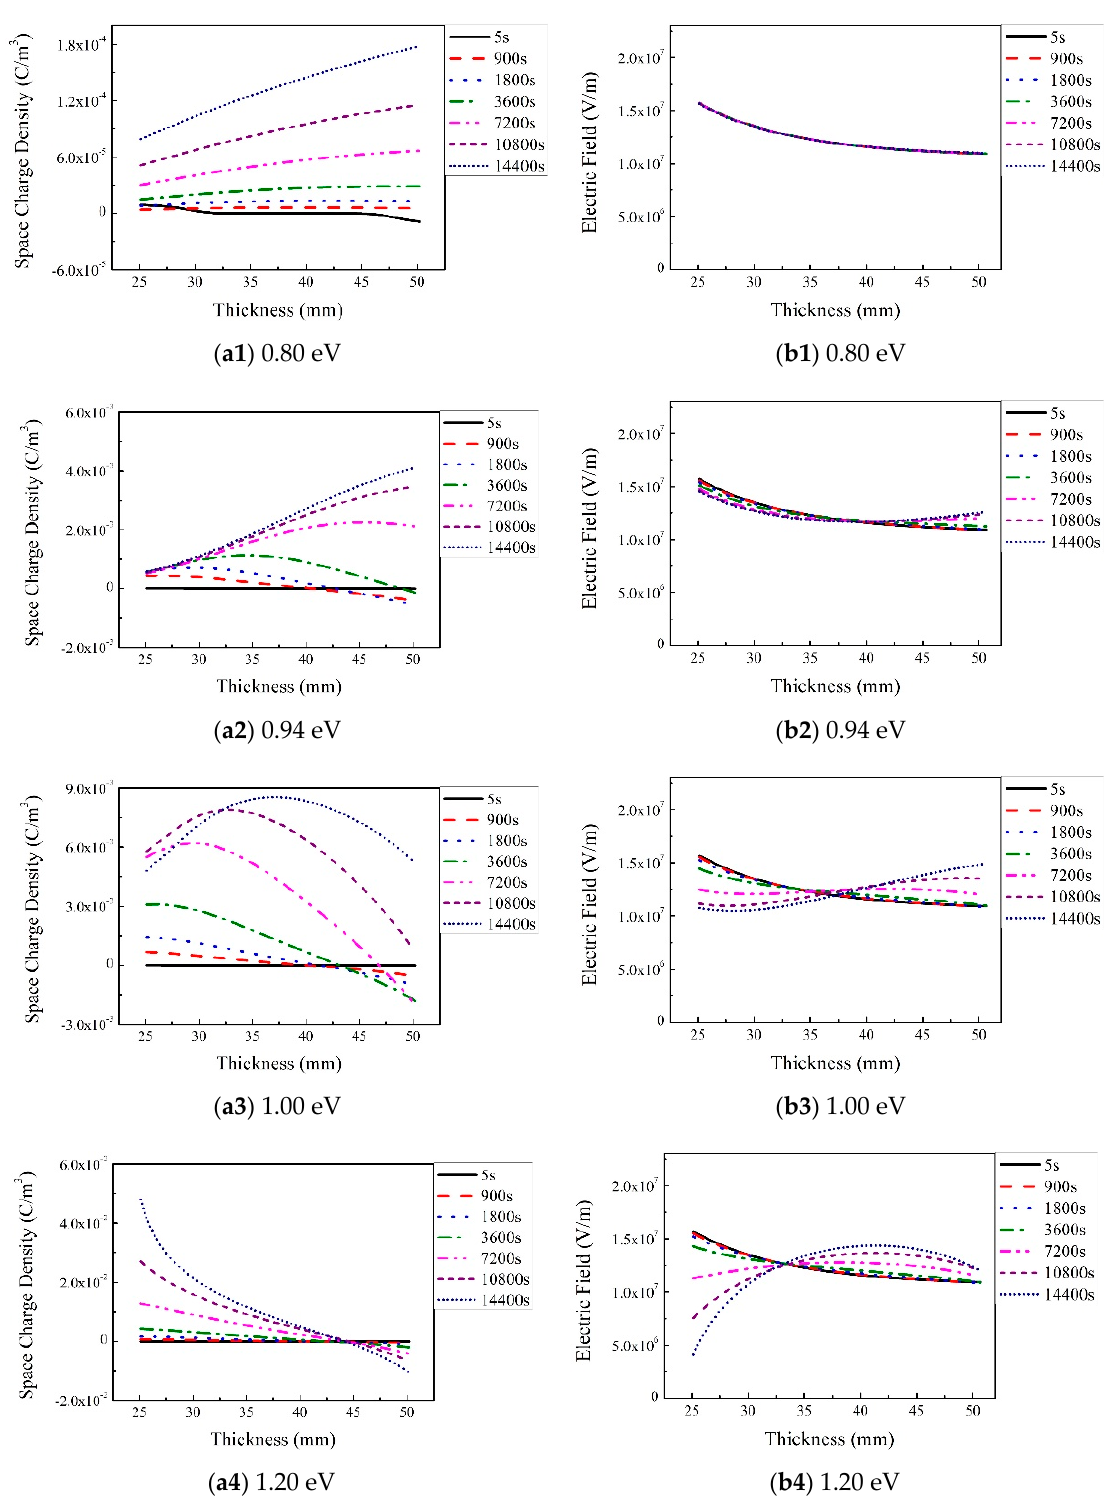
Figure 2. Simulation results of space charge distribution ( a1 - a4 ) and electric field distribution ( b1 - b4 ) in 320 kV HVDC cable insulation when the trap depth varies from 0.80 to 1.20 eV with the trap density of 10 × 10 19 m − 3 and load current of 1800 A.